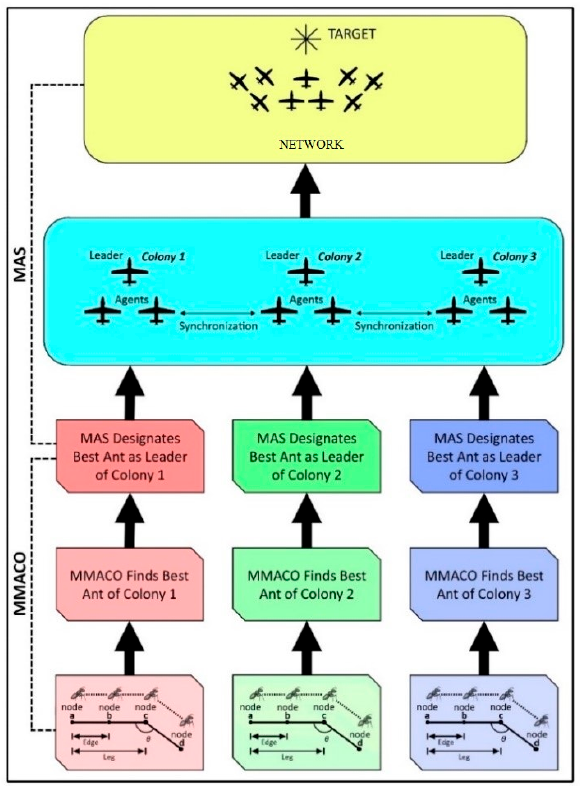
Figure 3. The Solution Framework.